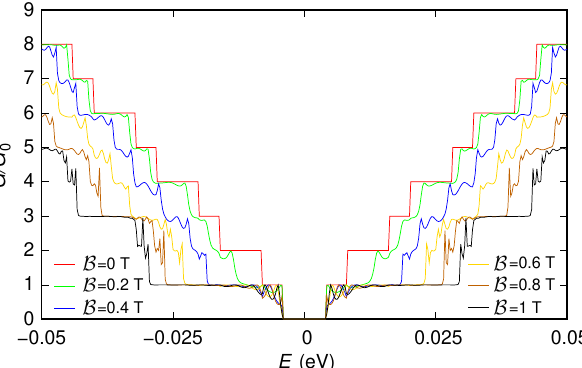
Figure 7. Conductance G , normalized with respect to the conductance quantum G 0 , which was obtained as a function of the Fermi energy E for six values of the orthogonal magnetic field B for the 150 nm-wide and 300 nm-long graphene ribbon with zero potential and without including the contacts, using the “second gauge”. These results are not correct, since the absence of contacts limits the number of modes injected into the structure.